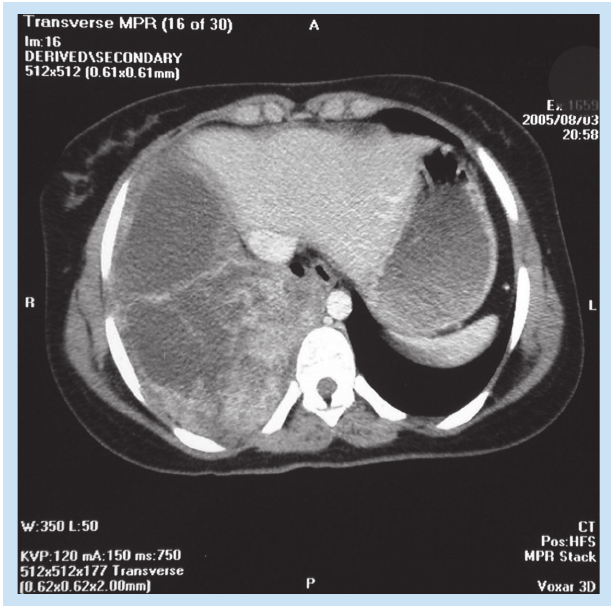
Fig. 2. The post-contrast CT image through the lower chest and upper abdomen demonstrates heterogeneous enhancement of the mass.